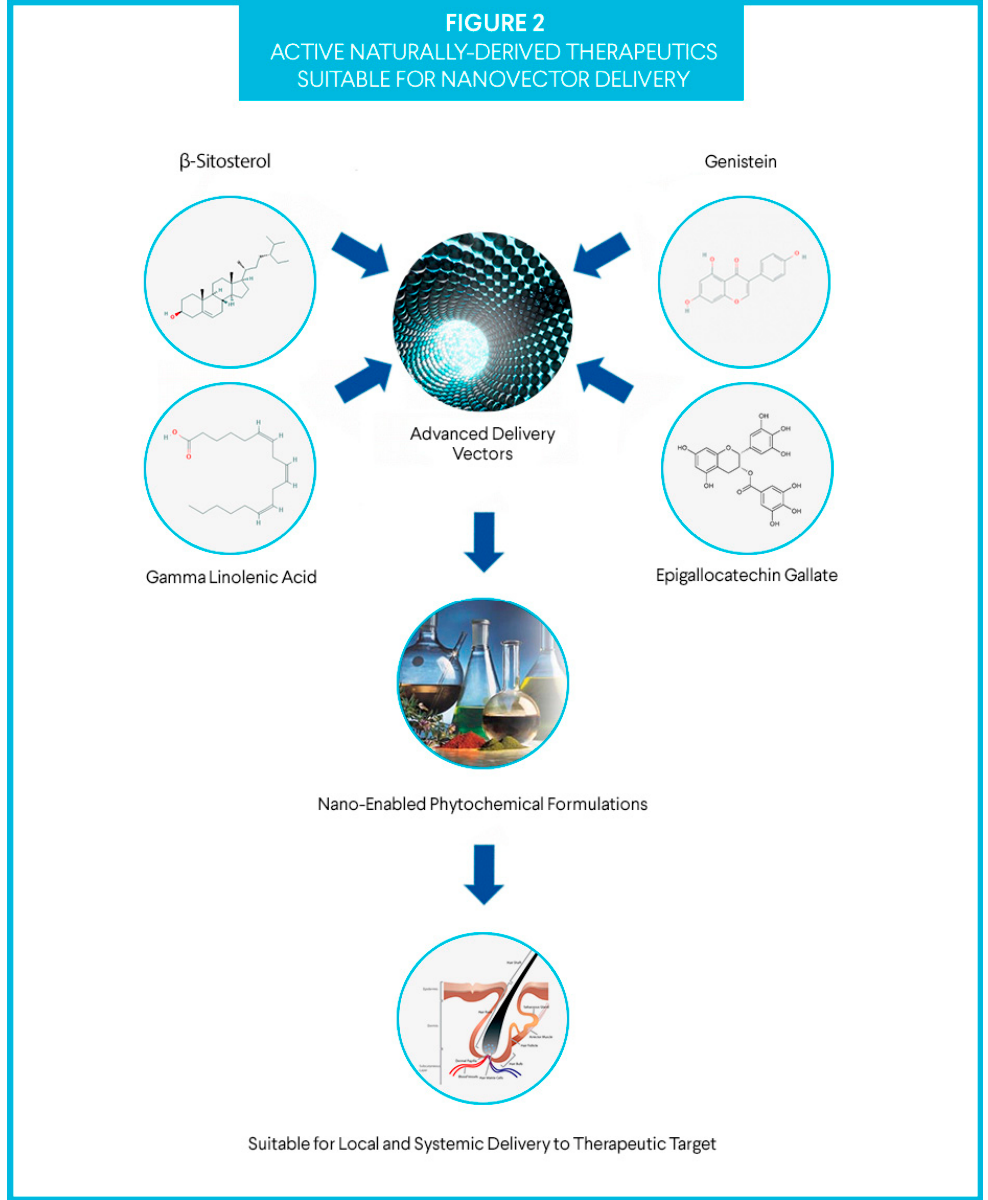
Figure 2. Active, naturally derived therapeutics suitable for nanovector delivery.